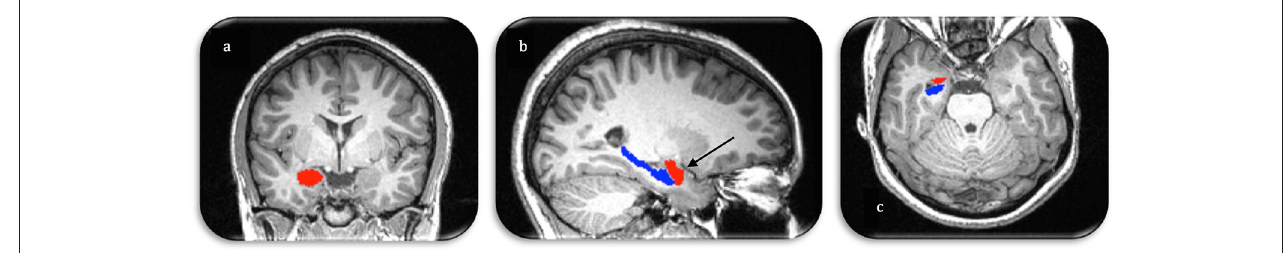
FIGURE 1 | Manual segmentation of the right amygdala (red) and hippocampus (blue) in three image planes (A. coronal, B. sagittal, C. axial). Arrow demonstrates the anterior boundary of the amygdala as visualized in all three orthogonal